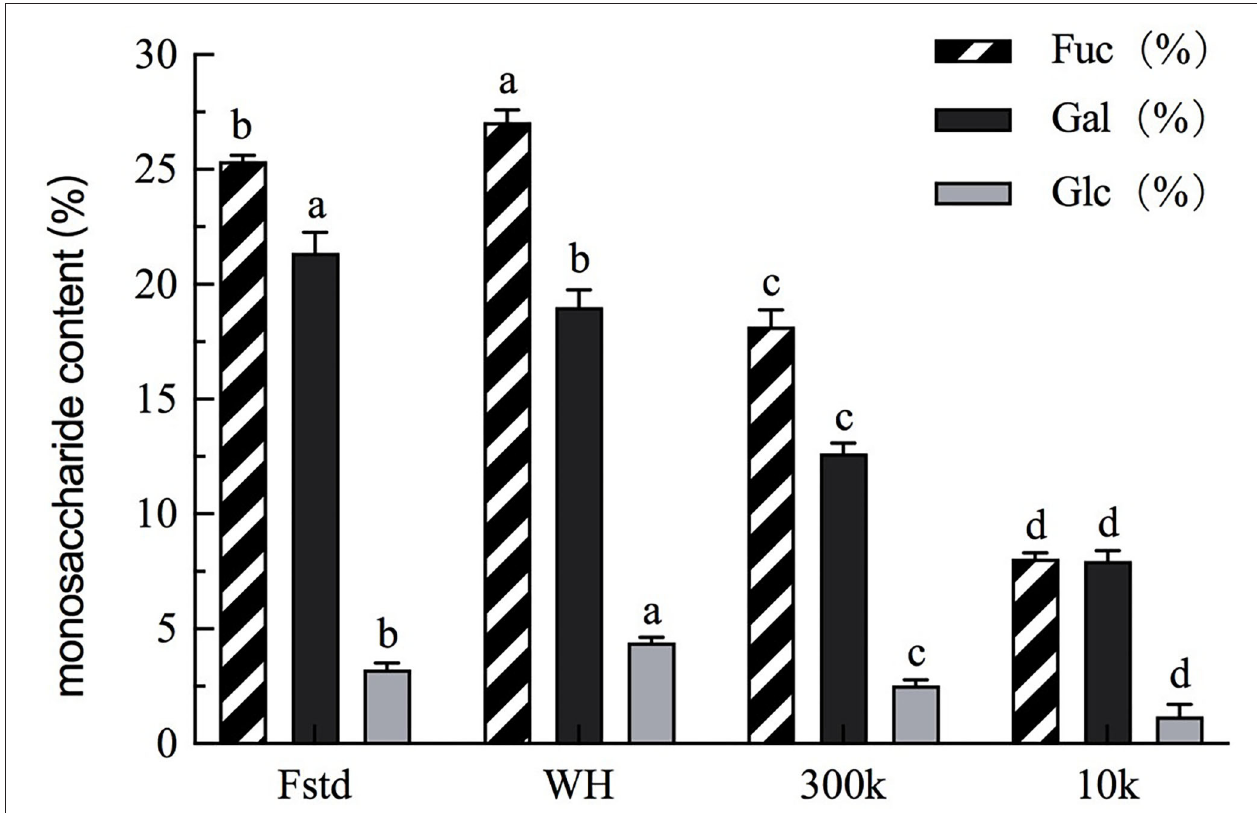
FIGURE 2 | Monosaccharide content of each fucoidan sample. Fstd = fucoidan standard ( ≥ 95%, CAS: 9072-19-9). WH = fucoidan crude extract. 300k = fucoidan fraction with molecular weight over 300 kDa. 10k = fucoidan fraction with molecular weight < 10 kDa. Values are expressed as mean with standard deviation ( n = 3). Within each column, mean values with different superscript lowercase letters are statistically different ( p <